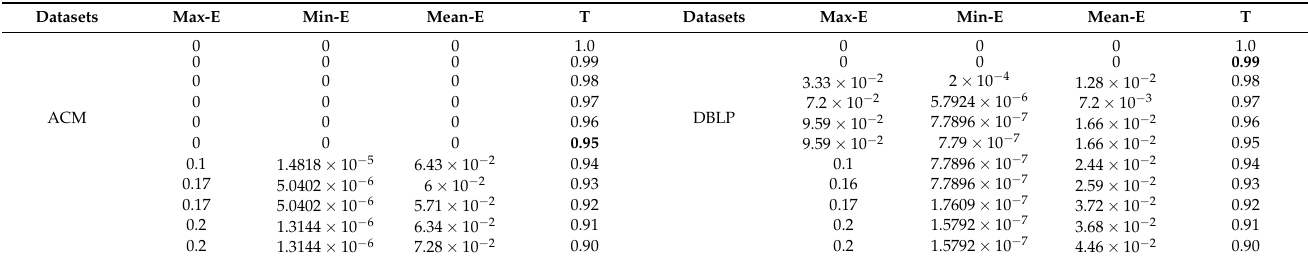
Table 4. Results of maintainability mining by PathSim algorithms. Max-E: maximum error, Min-E: minimum error, Mean-E: mean error, T: